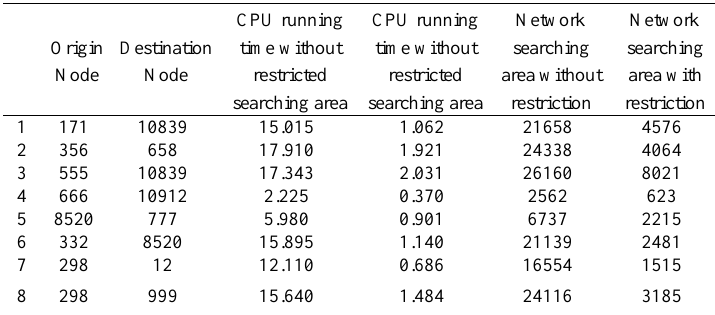
Table 2. Efficiency test in Guangzhou